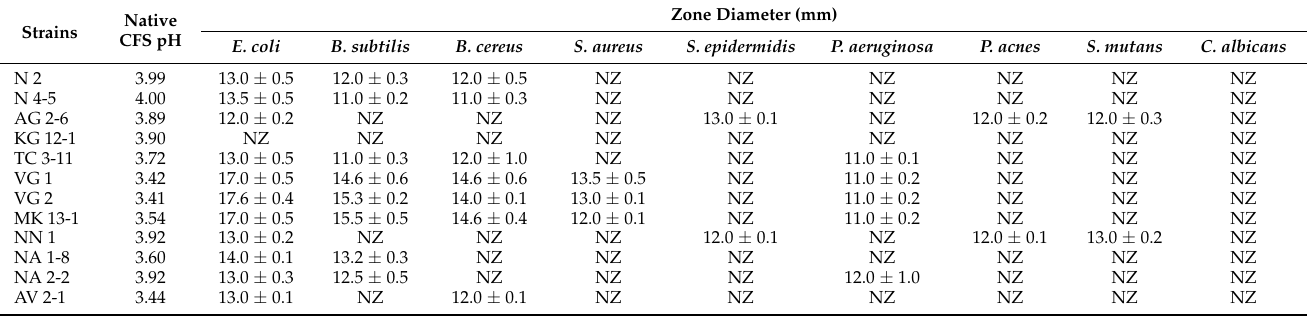
Table 3. Antimicrobial activity of the newly isolated lactic acid bacterial strains (native cell free supernatant) against test